Question: Identify the chart type used in this figure.
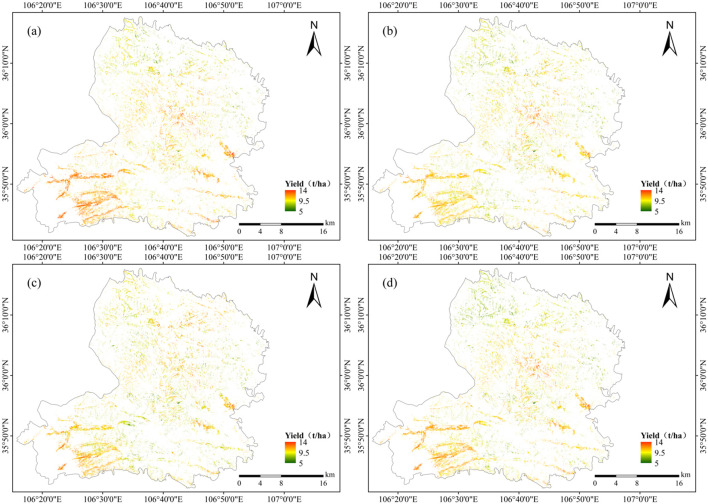
Answer: histogram